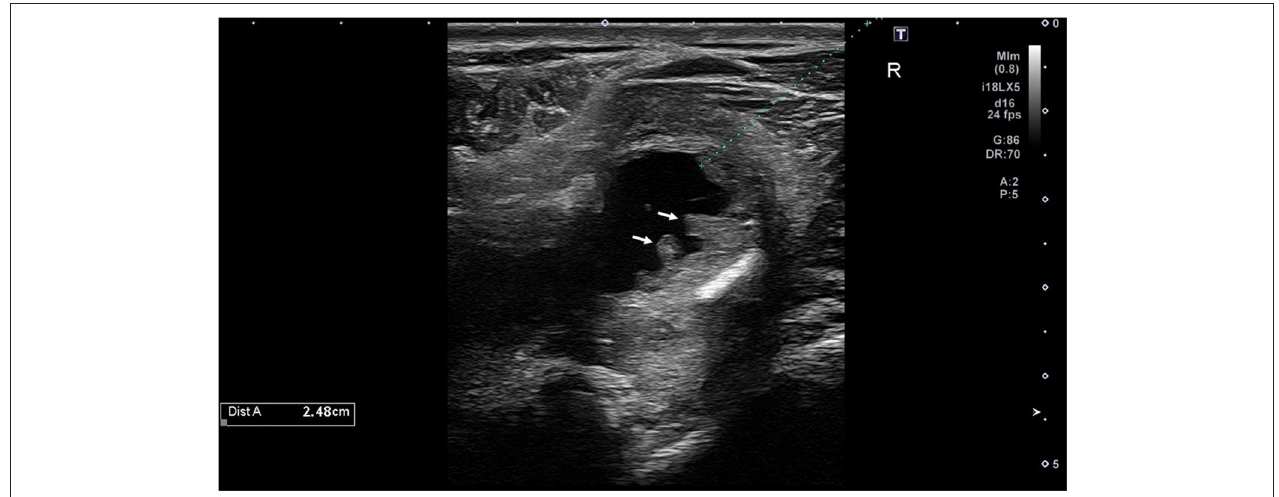
FIGURE 3 | Bursoscopy image showing synovial proliferation within the cranial nuchal bursa.